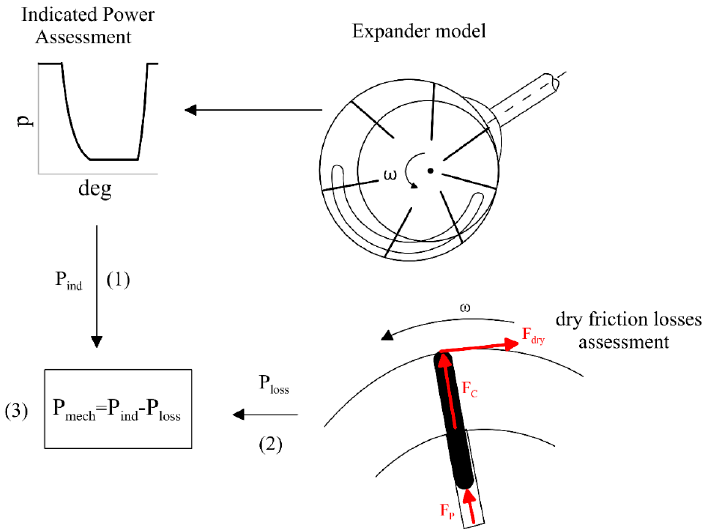
Figure 3. Mechanical section of the theoretical model. Step (1) Evaluation of indicated power as the area of the indicated cycle; Step (2) Evaluation of the power loss due to friction at tip blade; Step (3) Mechanical power evaluation as the difference between indicated power and power loss.